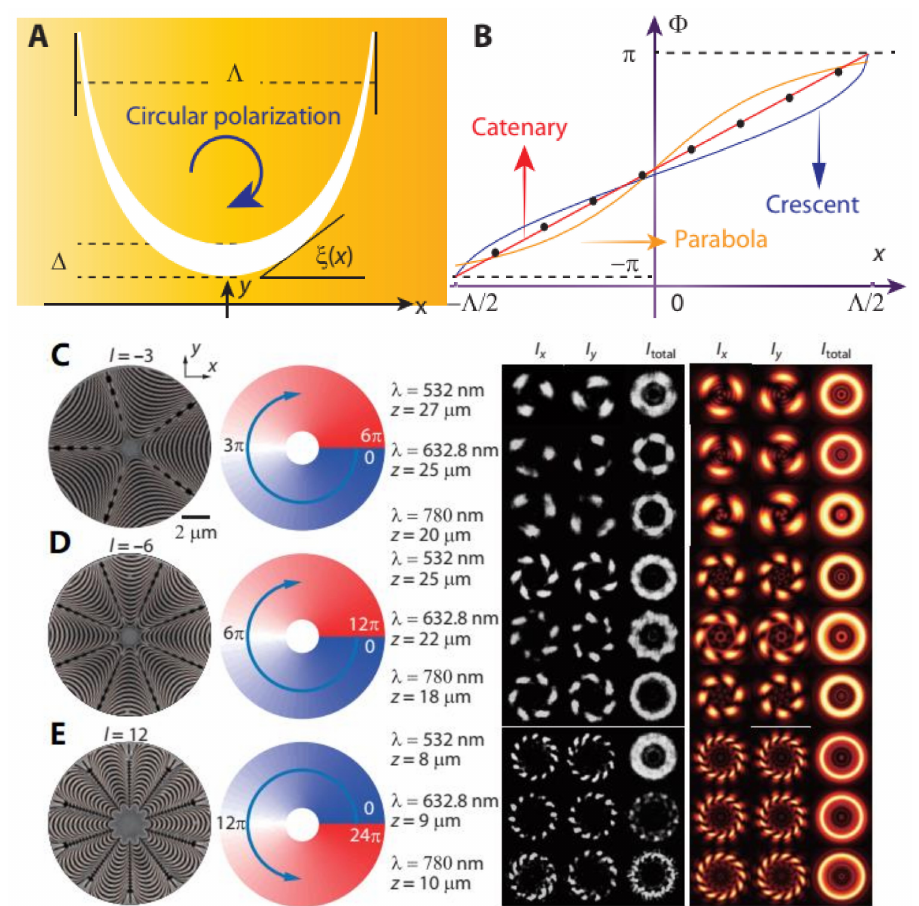
Figure 12. Catenary structure as a special type of meta-atom for P–B phase modulation under the incidence of circular polarization; ( A ) the catenary atoms with varying tangent angle from − π /2 to π /2 and ( B ) corresponding phase tailoring from − π to π , and topological charges of ( C ) − 3, ( D ) − 6 and ( E ) 12 by the catenary-based OAM generator (first column), in accordance with the helical phase profile (second column) and the simulated (third column) and experimentally demonstrated intensity pattern. All figures are reproduced with permission from